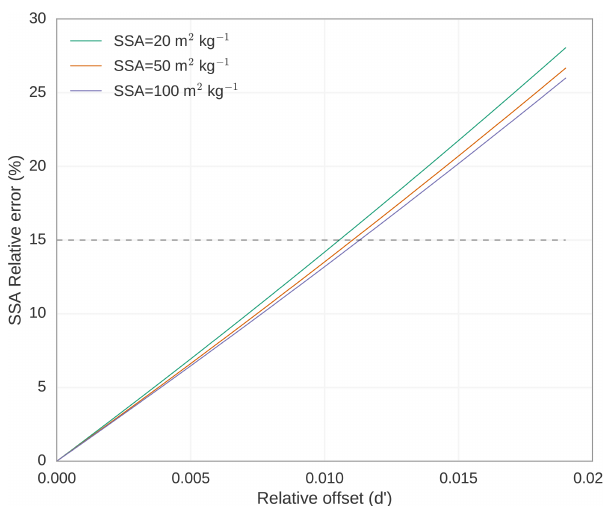
Figure 2. Theoretical calculation of the relative error in SSA due to an offset in the incident and reflectance spectra for SZA = 60 ◦ . The dashed line shows the 15% target accuracy discussed in the